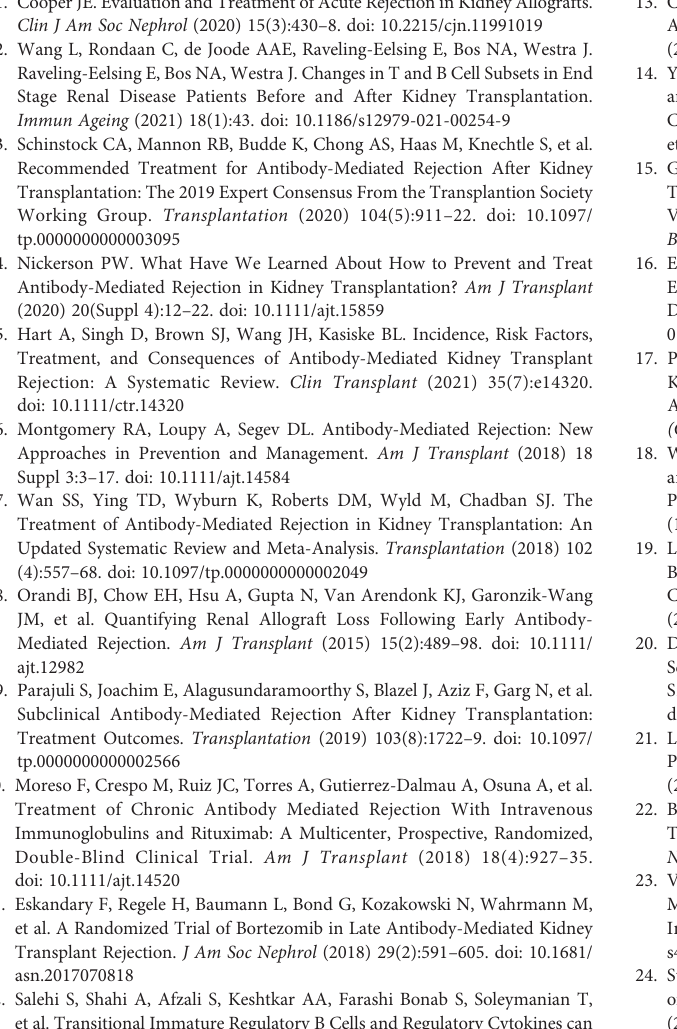
Supplementary Table 2 | Cell types and corresponding marker genes. Supplementary Table 3 | List of Marker genes for T cells subtype subdivision.